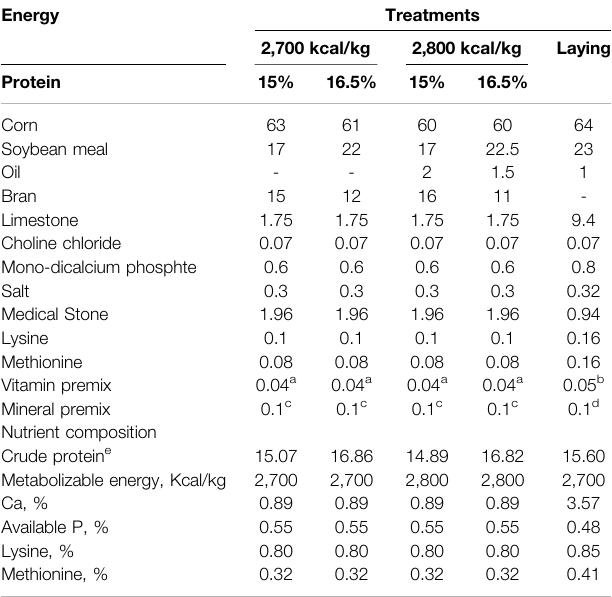
TABLE 1 | Experimental diets and nutrient compositions.